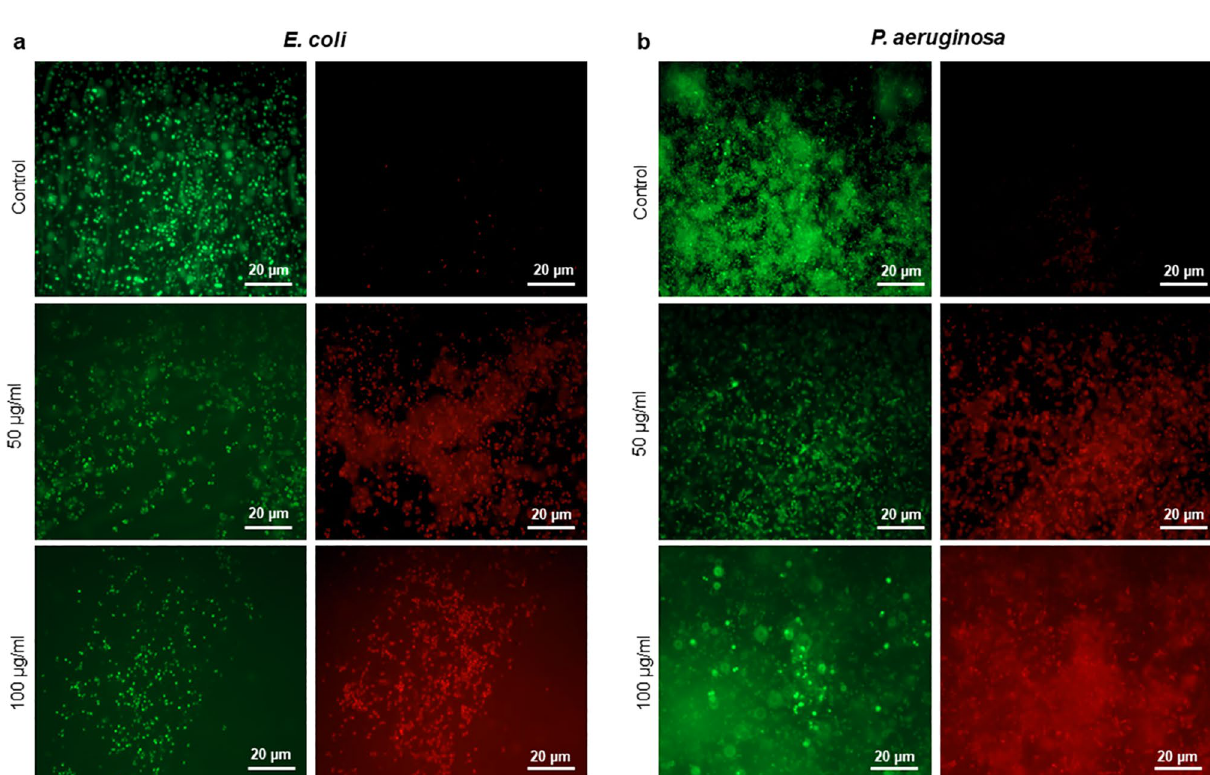
Figure 9. Live/dead staining image of biofilms observed by using fluorescence microscopy, ( a ) E. coli and ( b ) P. aeruginosa . Live cells stained green and dead cells stained